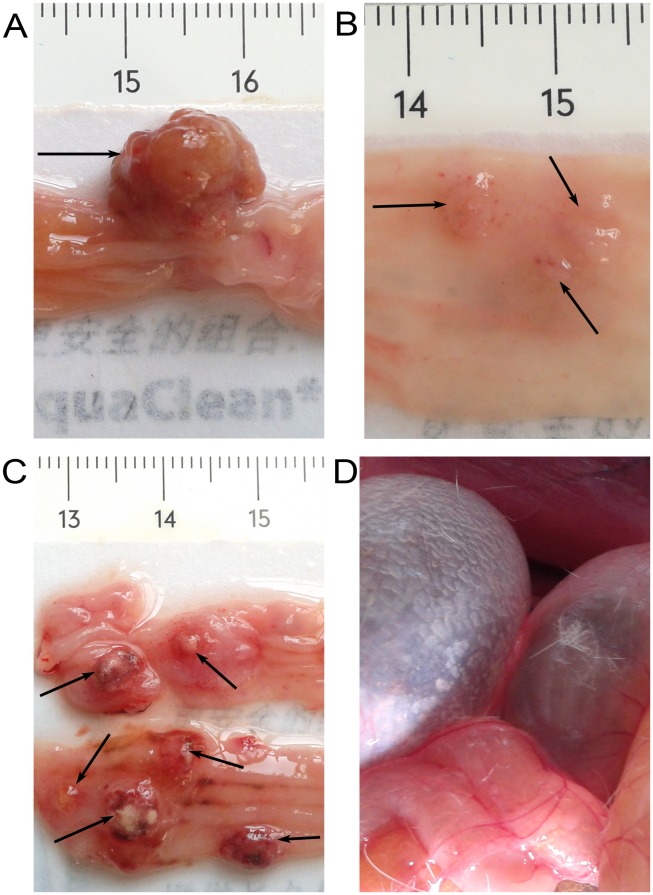
Tumor tissues obtained from DMH-induced rats.Fig. 4A: The largest tumor obtained from the STZ+DMH group. Fig. 4B: Several small tumors together isolated from the DMH group. Fig. 4C: Several tumors collected from one rat in the STZ+DMH group. Fig. 4D: Tumor growth in the intestinal lumen interfering with bowel movements, resulting in difficult defecation and building of gas in the intestine in some rats.